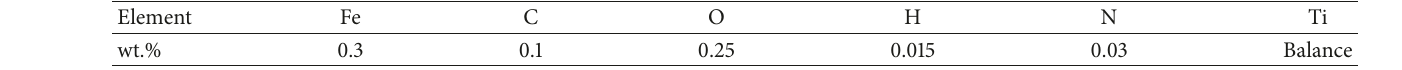
Table 1: Chemical composition of titanium Grade 2.